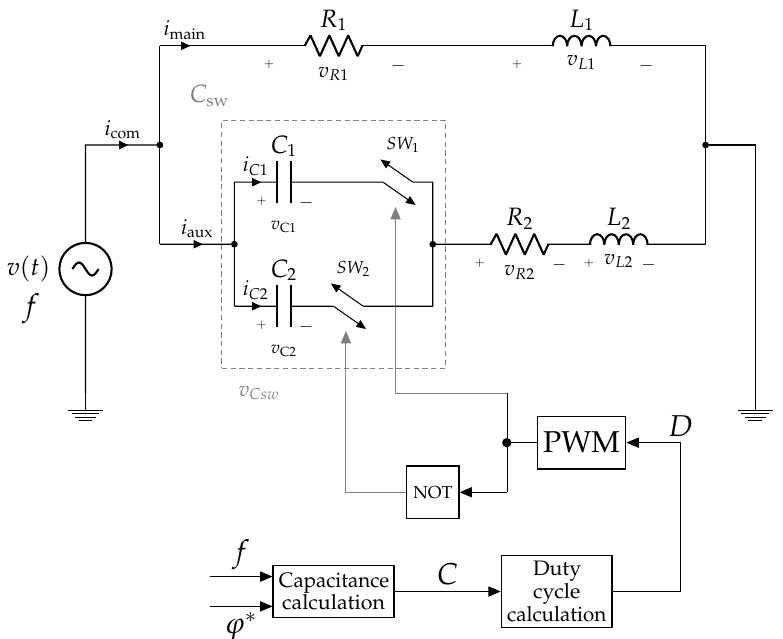
Figure 12. Block diagram of the open-loop control of current phase